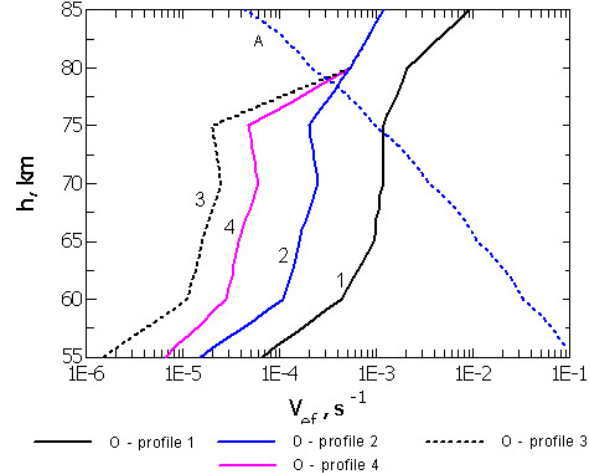
Fig. 3. Height profiles of reaction efficiencies. Curve A is effi- ciency of the reaction in which cluster NO + .(H 2 O) interacts with H 2 O: NO + .(H 2 O)+H 2 O+N 2 → NO + .(H 2 O) 2 +N 2 . Curves 1–4 are efficiencies of the reaction in which cluster NO + .(H 2 O) interacts with atomic oxygen: NO + .(H 2 O)+O → NO + +H 2 O based on O-profiles 2